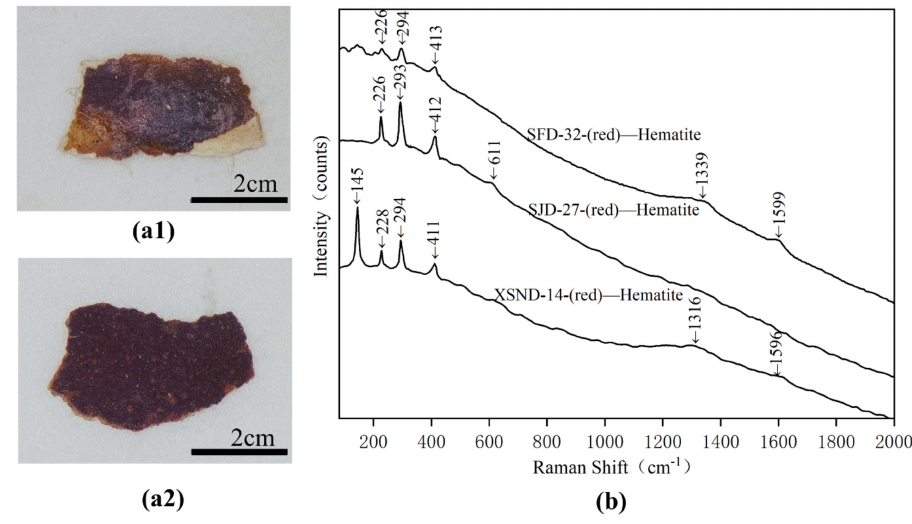
Figure 9. Digital microscopy (DM) of red samples ( a1 ) XSND-14; ( a2 ) SJD-27) and Micro-Raman spectroscopy ( b ) SFD-32; SJD-27 and XSND-14.